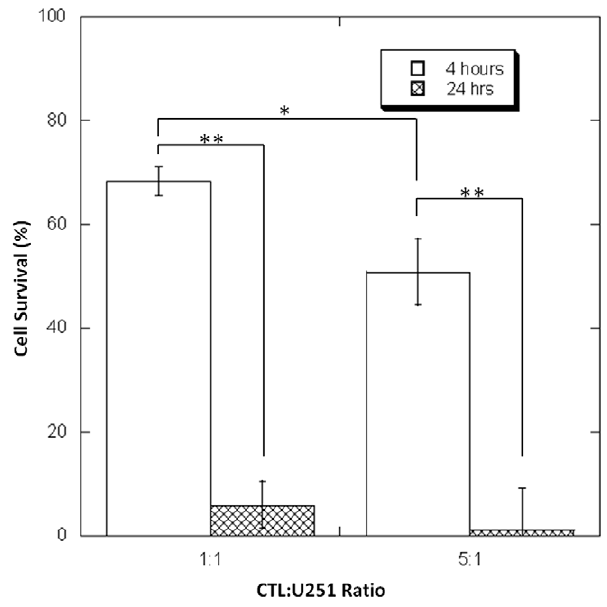
Figure 5. Cytotoxicity of post-migration IL-13 zetakine CTLs. Post-migration IL-13 zetakines were co-cultured with U251 glioma cells at a ratio (CTL:U251) of 1:1 or 5:1. The viability of U251 cells was determined using the Dual-Glo Luciferase Assay after 4 hours (A) and 24 hours (B) of incubation time. Increasing the co-culture ratio to 5:1 significantly decreased glioma cell survivability (* p , 0.01). Regardless of the co-culture ratio, glioma cells died in a time-dependent manner (** p , 0.001). The data represents the means 6 SD of three independent experiments.